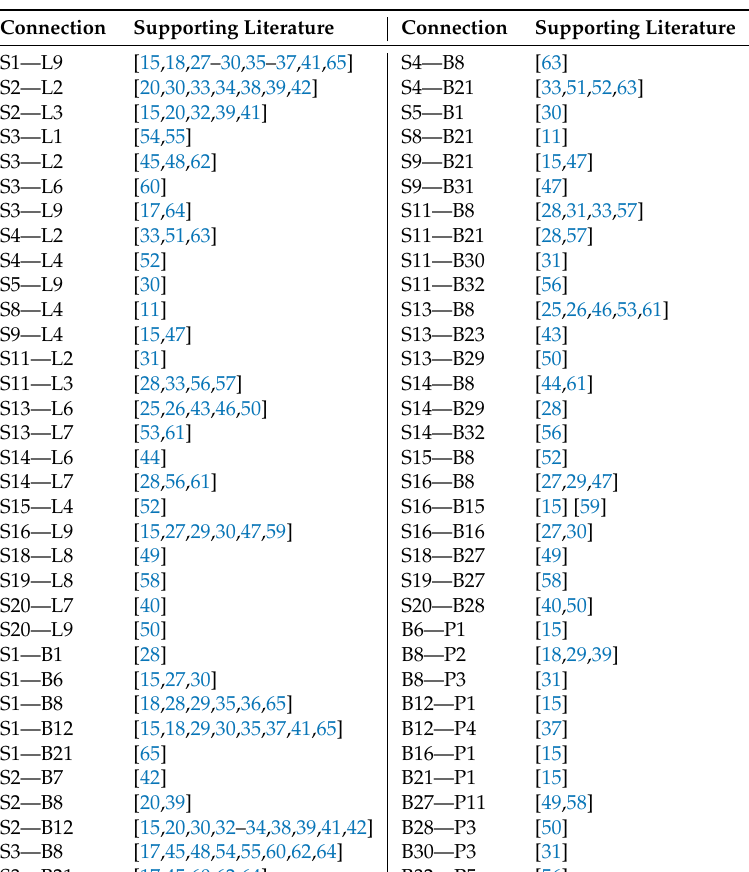
Table 2. Mapping connections to